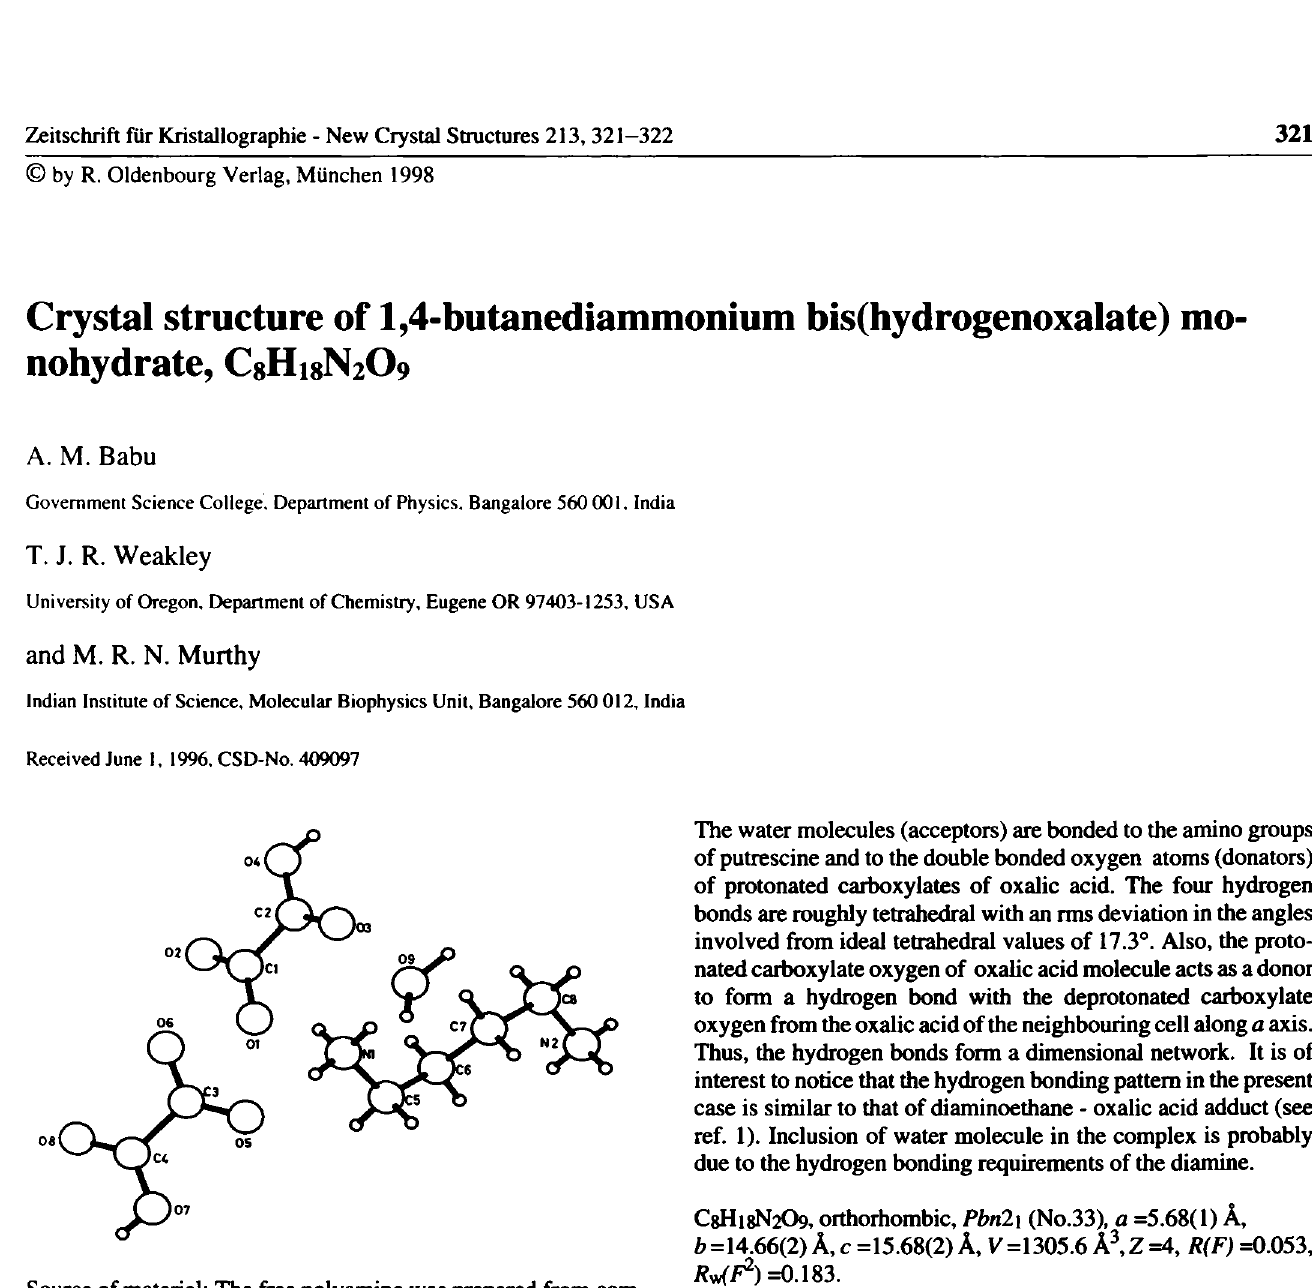
Table 1. Parameters used for the X -ray data collection